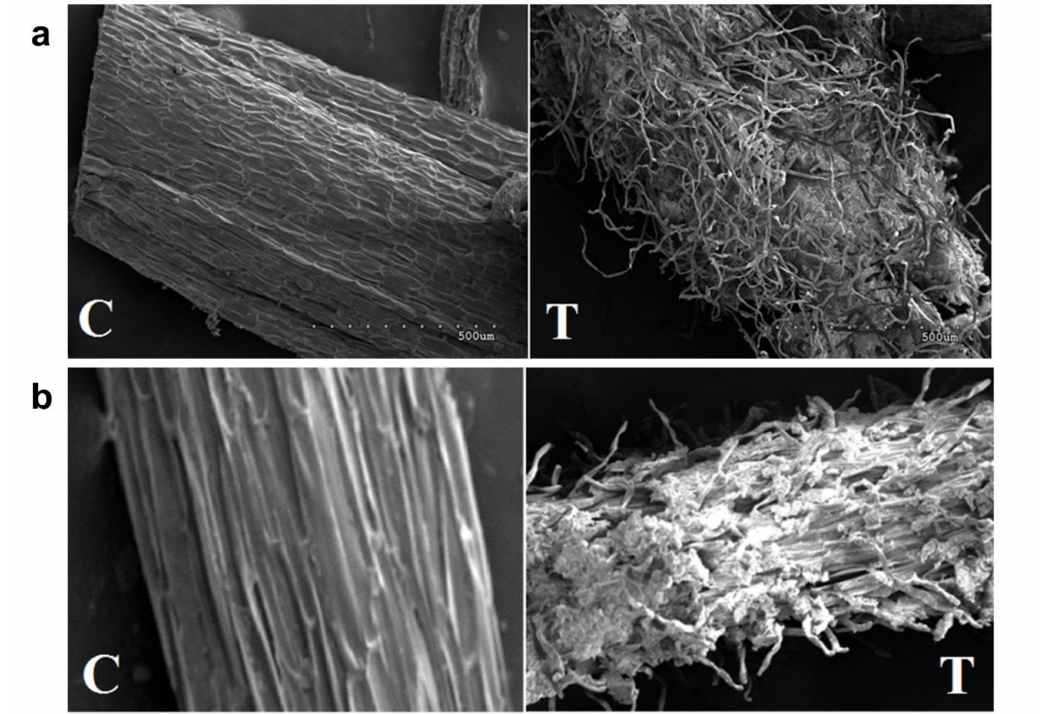
Figure 1. Root elongation zone photographed using electron microscope. ( a ) Roots of SAS; ( b ) roots of TAS. C = control ( − Al); T = treatment ( + Al). The images in ( a ) and ( b ) have the same scale and represent 500 µ